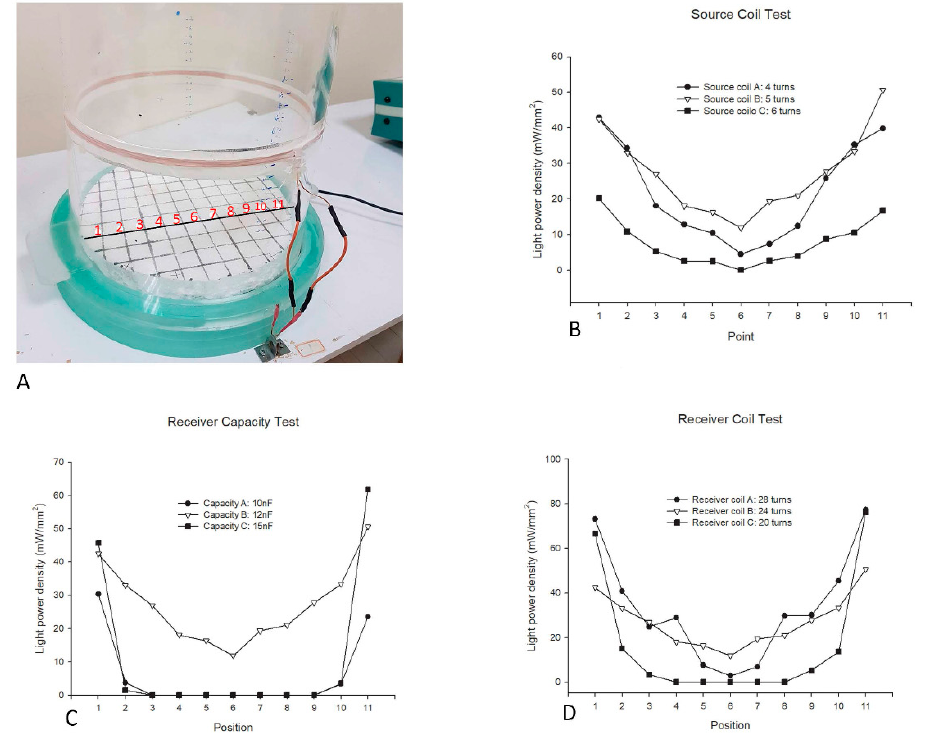
Figure 2. The wireless magnetic resonance device’s parameters. ( A ) The device’s light power density at the different points of a flexible ground (from 1–11) were tested. ( B ) Different turns of the source coil. ( C ) Different receiver capacities. ( D ) Different turns of the receiver coil.